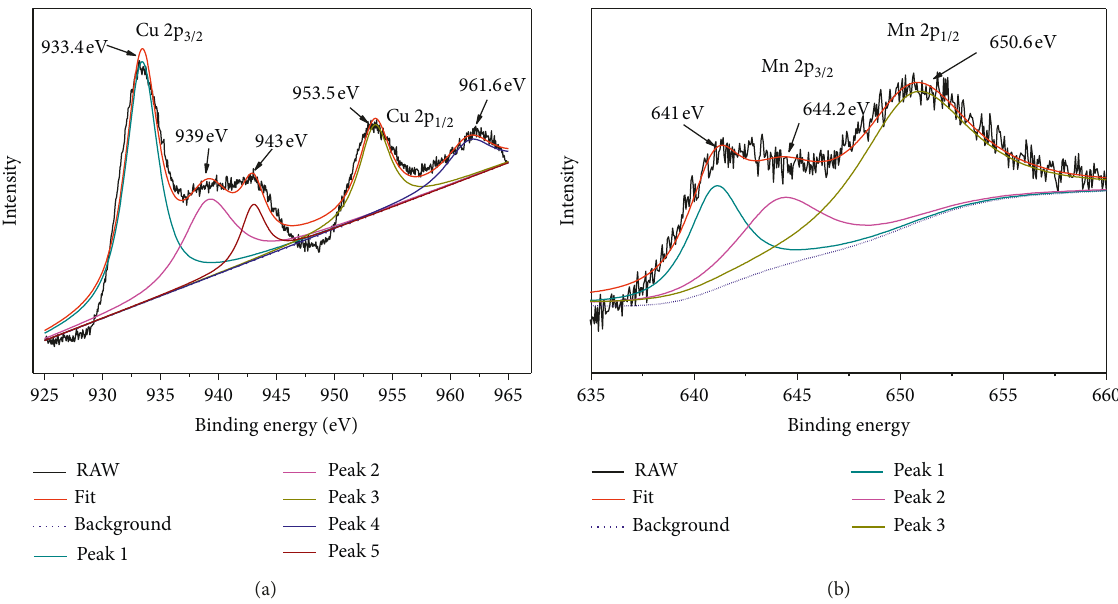
Figure 4: Representative XPS spectra with deconvoluted and fitting results. (a) Cu 2p region and (b) Mn 2p for Mn@CuBTC-0.05.